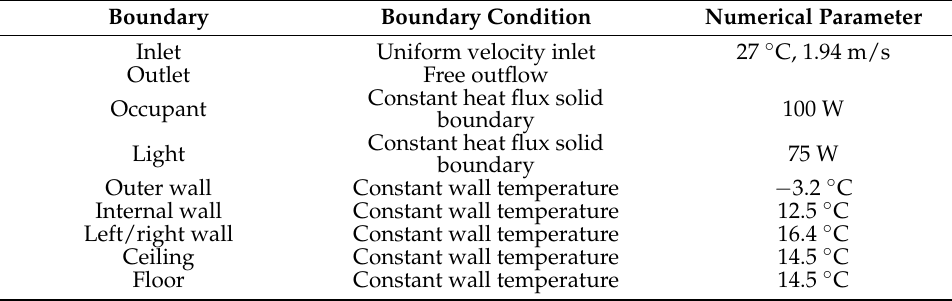
Table 2. Boundary conditions of CFD